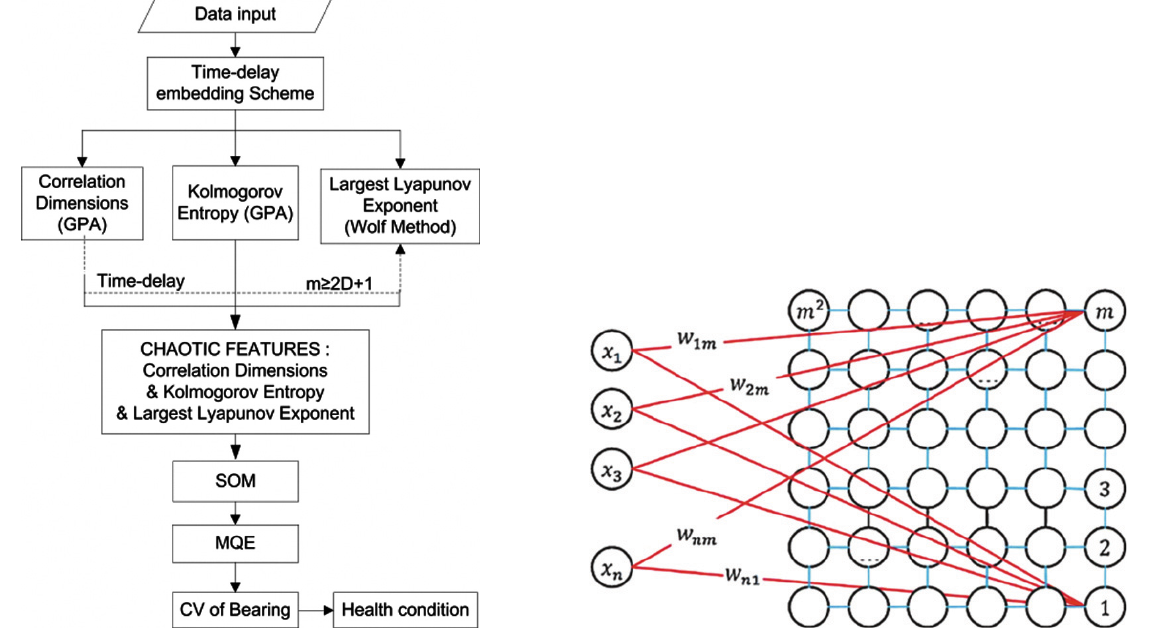
Fig. 1. Process of bearing health assessment. Fig. 2. Structure of SOM